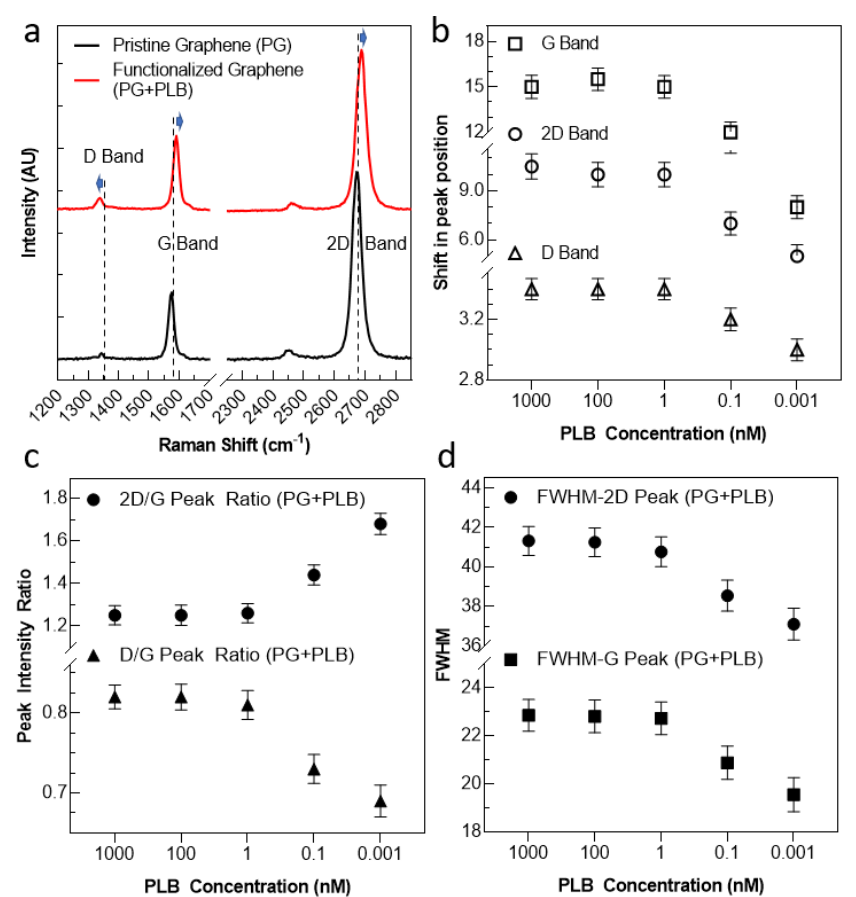
Figure 2. The Raman spectra analysis of our substrate before and after functionalization using various PLB concentrations. ( a ) Pyrene interacts with graphene rings by sharing its free electrons. ( b ) The synthesized PLB construct was tested (via middle/long-wave UV. ( c ) The peak ratios were plotted as a function of PLB molecule concentration. ( d ) The FWHM for 2D peak and G peak are illustrated as a function of PLB molecule concentration.